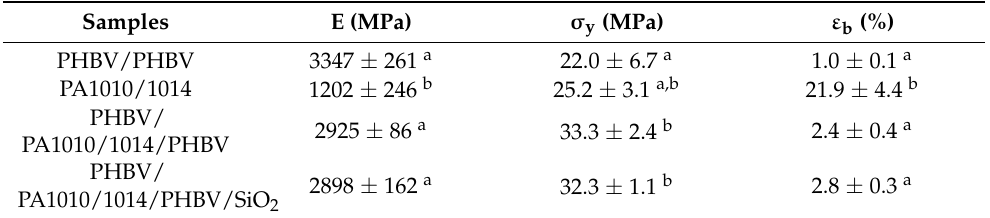
Table 6. Mechanical properties of the mono- and multilayer films based on PHBV, PA1010/1014, and SiO 2 .